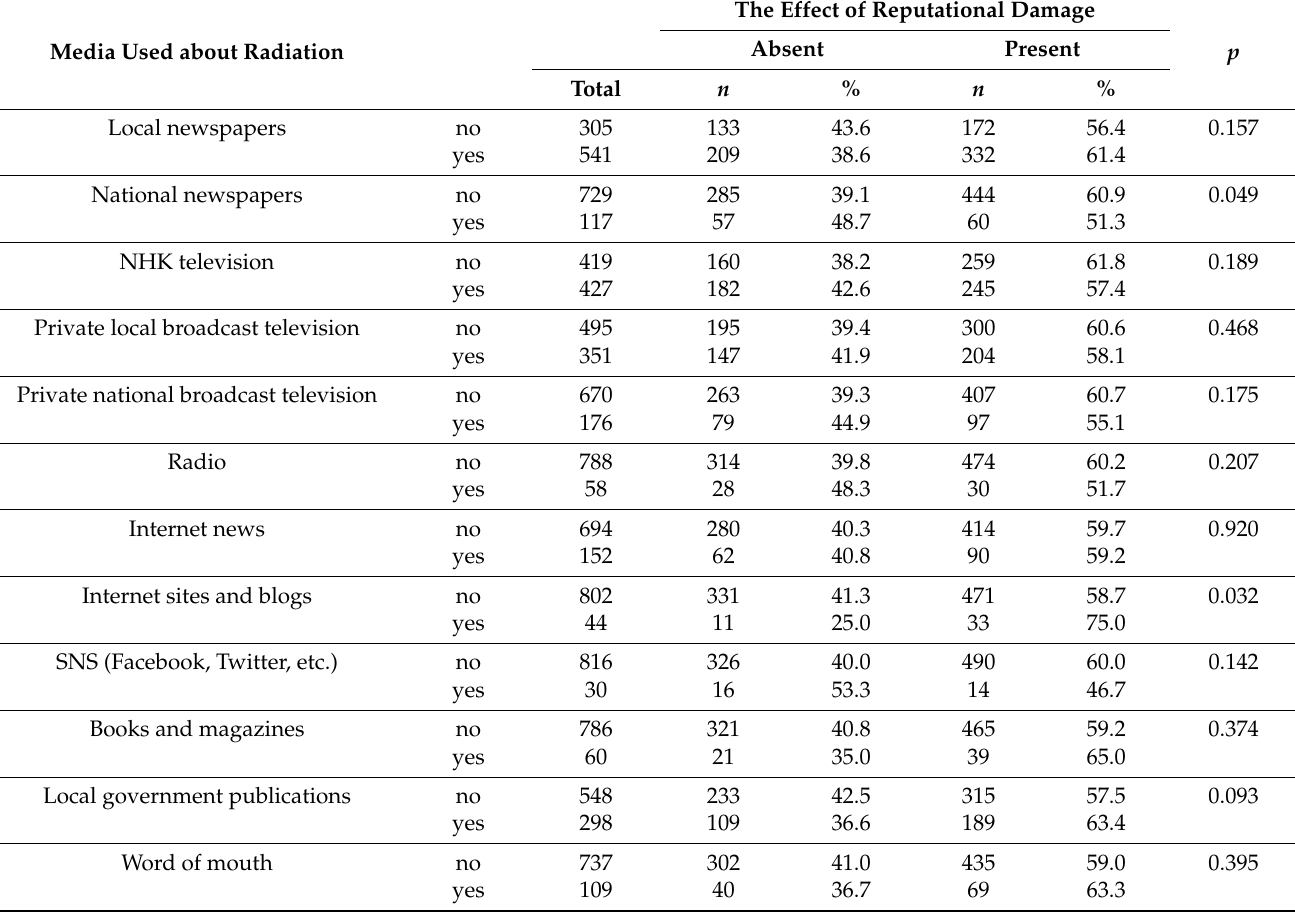
Table 4. Results of the univariate analysis for media used by respondents with the effect of perceived DCBHR damage as the response variable ( n =